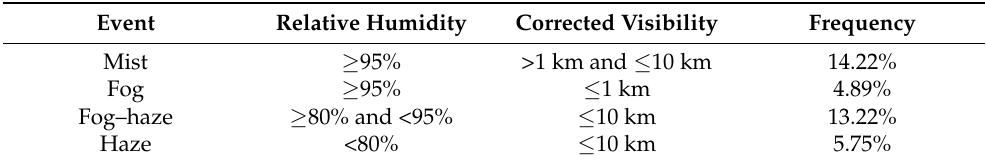
Table 1. Key criterion for different low-visibility events and frequency of occurrence in all weather types during October–December 2019. Event Relative Humidity Corrected Visibility Frequency Mist ≥ 95% >1 km and ≤ 10 km 14.22% Fog ≥ 95% ≤ 1 km